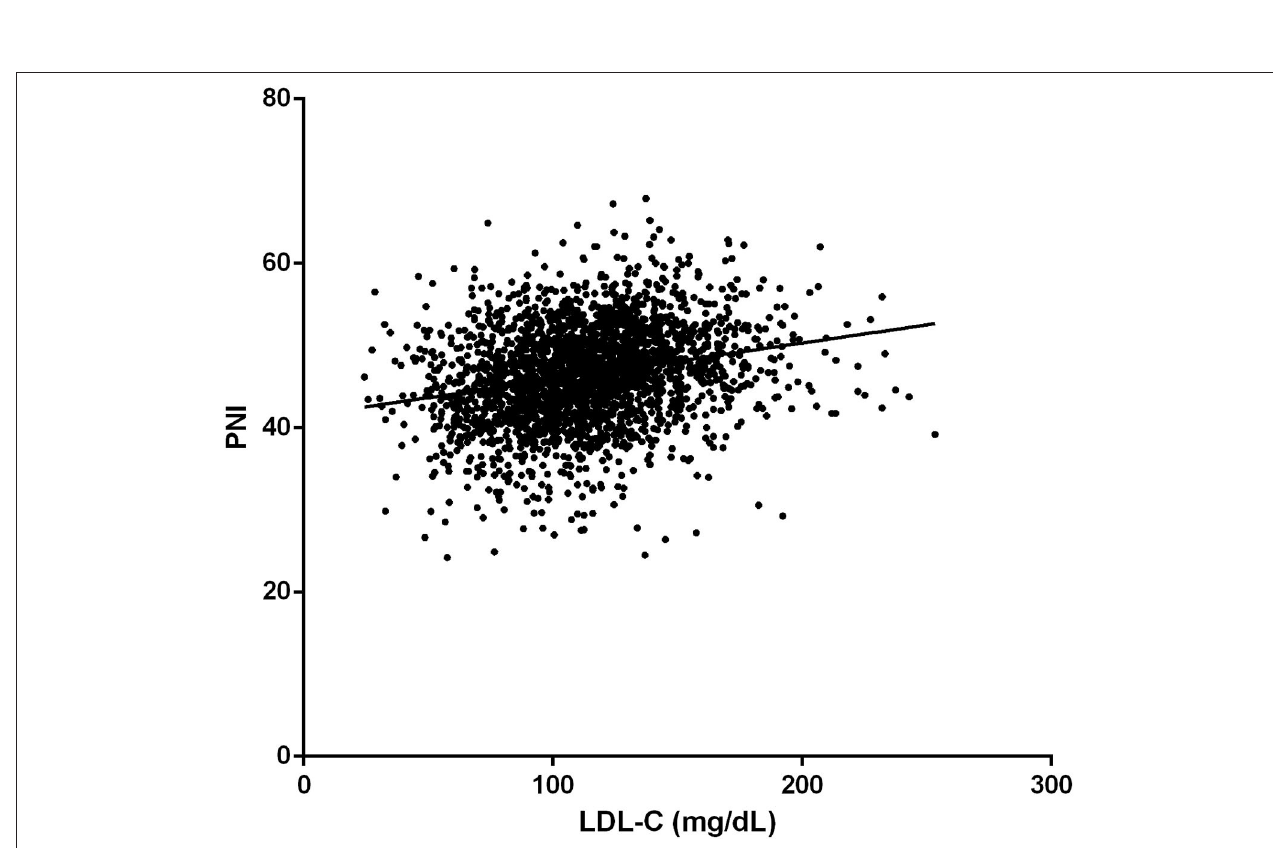
FIGURE 3 | The correlation of low-density lipoprotein cholesterol (LDL-C) and Prognostic Nutrition Index (PNI).